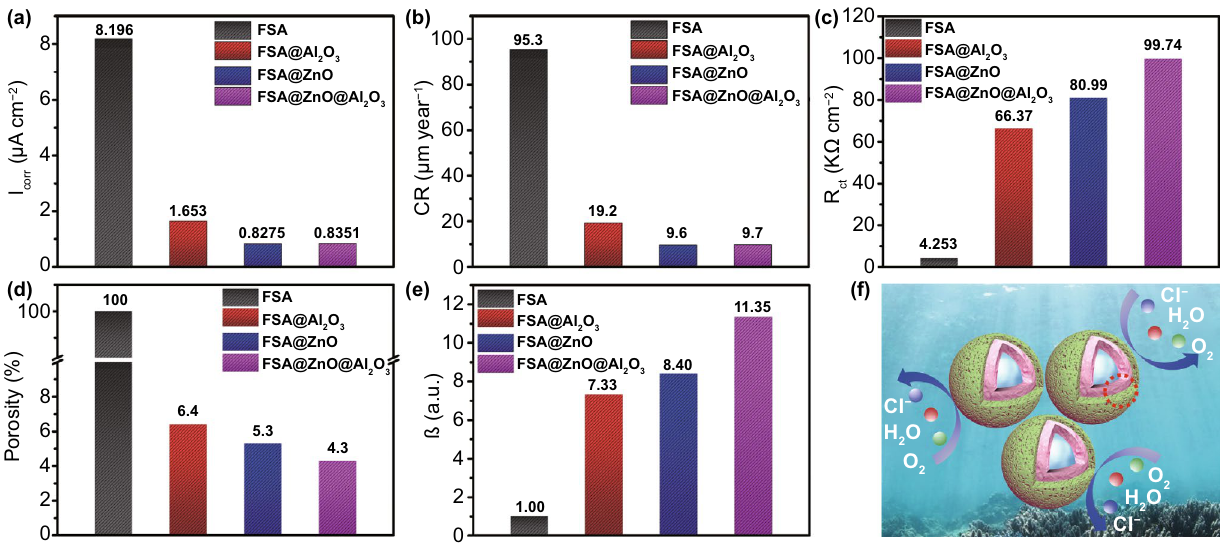
Fig. 5 a corrosion current I corr , b corrosion rate, c transfer resistance R ct , d the electrochemical porosity, e shielding-increase coefficient of FSA and FSA-based absorbers after immersion in 5.0 wt% NaCl solution, f anti-corrosion mechanism of the FSA@ZnO@Al 2 O 3 gradient